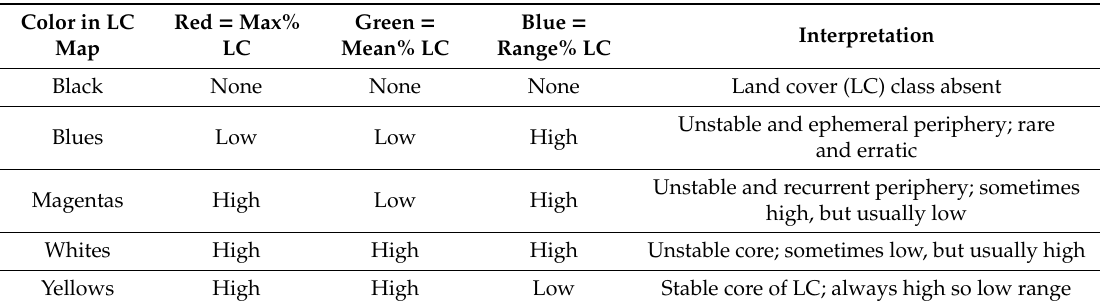
Table 1. Land cover persistency interpretative legend. The table shows how the color in the LC map arises from the false color composite of red, green, and blue color planes that display, respectively, the maximum percentage of LC class, the average percentage of LC class, and the range of percentages of LC class over a given study period. Modified from